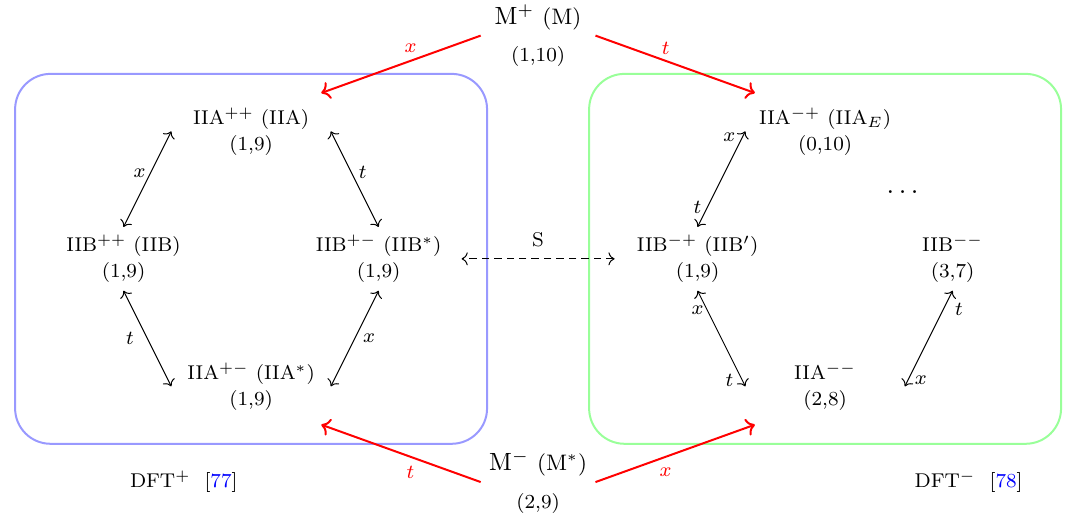
Figure 1 . The exotic duality web. Red arrows denote timelike or spacelike reductions from 11 to 10 dimensions. Black arrows denote T-dualities. The dashed arrow in the centre denotes S- duality. All these theories are described by choosing di(cid:11)erent parametrisations of exceptional (cid:12)eld theory. The superscript IIA/B (cid:6)(cid:6) denotes whether, (cid:12)rstly, fundamental strings and, secondly, D- branes have Lorentzian or Euclidean worldvolumes, and hence determines which gauge (cid:12)elds have wrong sign kinetic terms. Similarly M (cid:6) denotes whether M2 branes have Lorentzian or Euclidean worldvolumes. There are additional versions of these theories with more exotic signatures. The alternate names in brackets are those used originally by Hull [75, 76], while the plus minus notation and form of the diagram is taken from